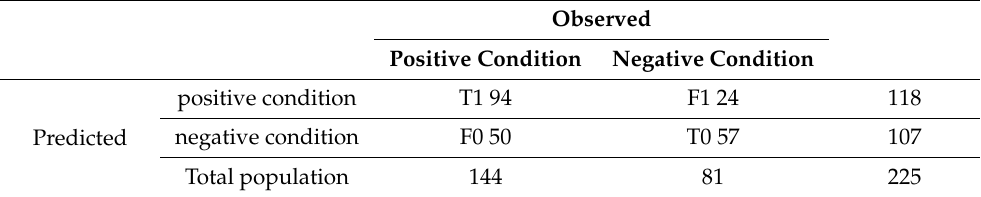
Table 5. Confusion matrix deriving from Canonical Discriminant Analysis (CDA) applied on catego- rial data set (0, uninfected; 1, infected). Observed Positive Condition Negative Condition positive condition T1 94 F1 24 118 negative condition F0 50 T0 57 107 Predicted Total population 144 81 225